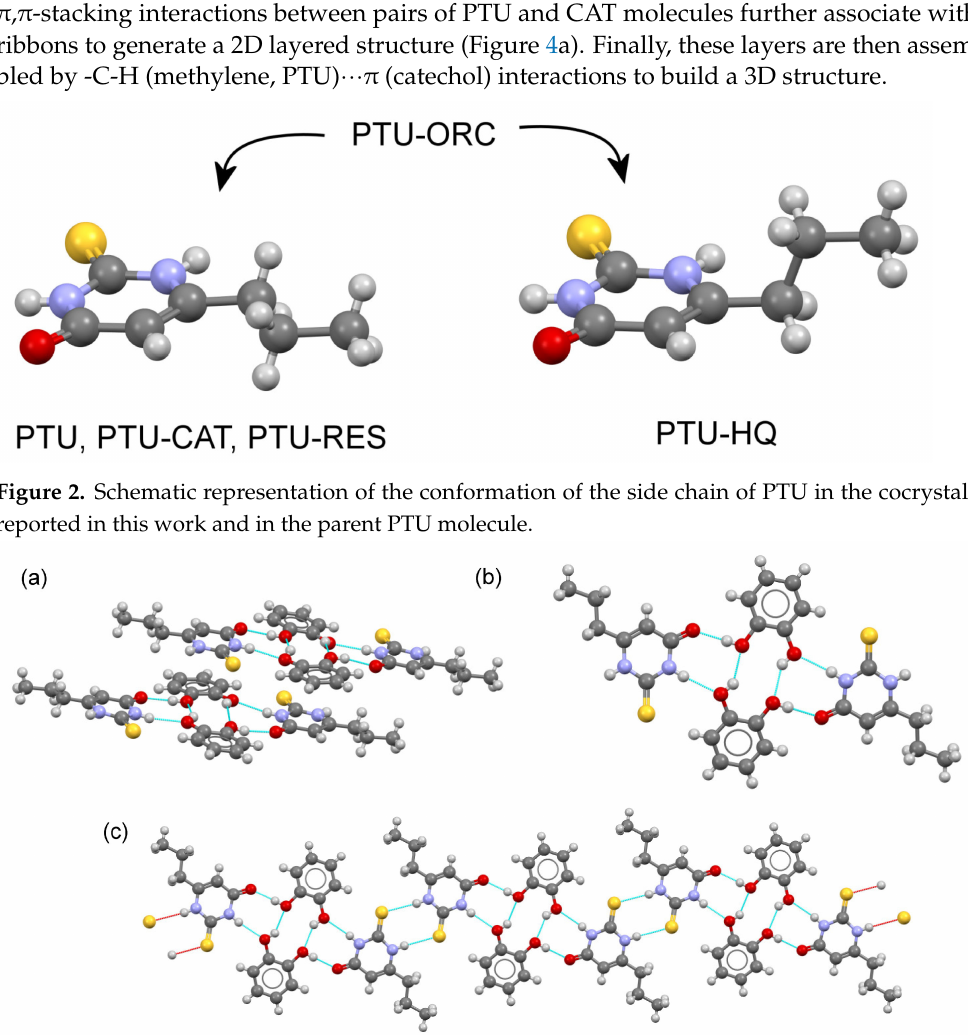
Figure 3. ( a ) Asymmetric unit in the cocrystal PTU–CAT. ( b ) Detailed view of the tetrameric structure. ( c ) Fragment of the ribbon structure in